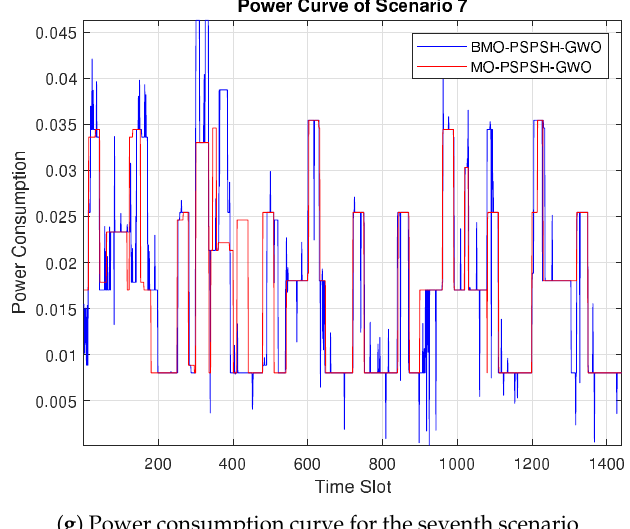
Figure 8. Power consumption curve for all scenarios using MO-PSPSH-GWO and